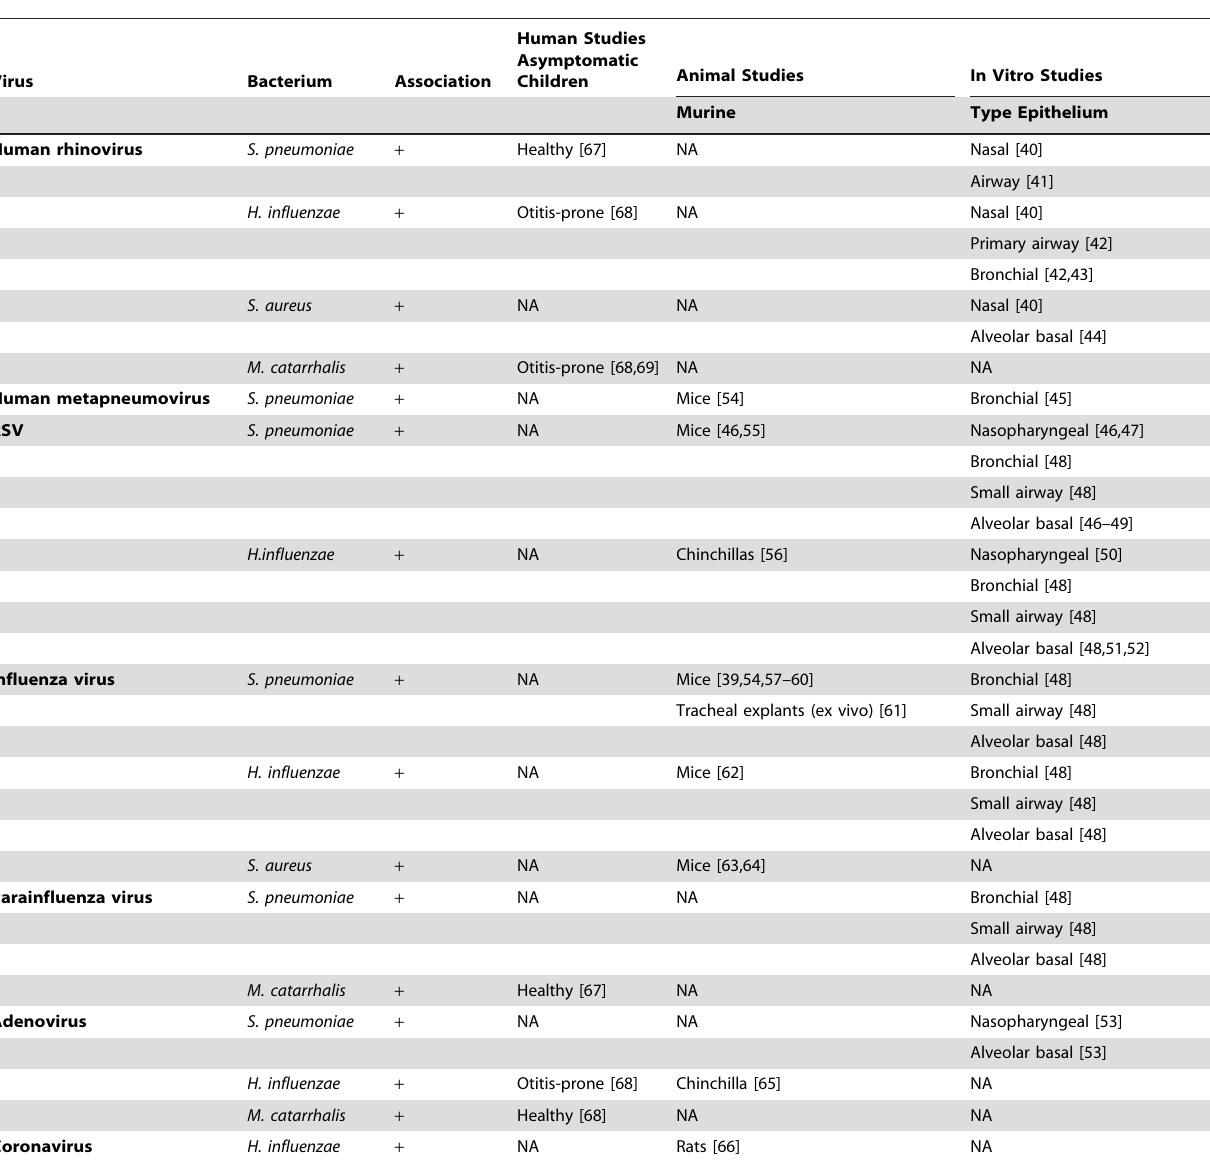
Table 1. Viral–bacterial interaction based on data available from human, animal, and in vitro studies.